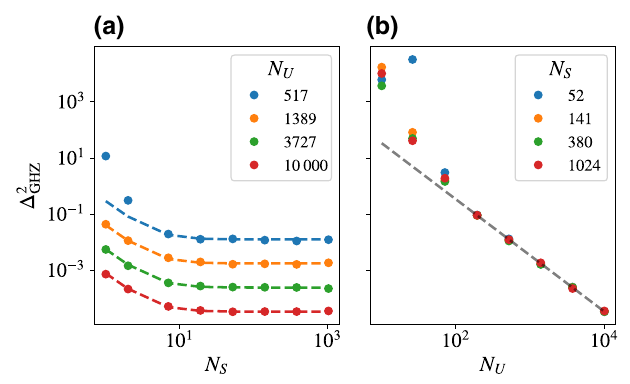
for a five- GHZ = ( 3384 / N 2 )( 1 + 22 / N 2 ) . U GHZ S